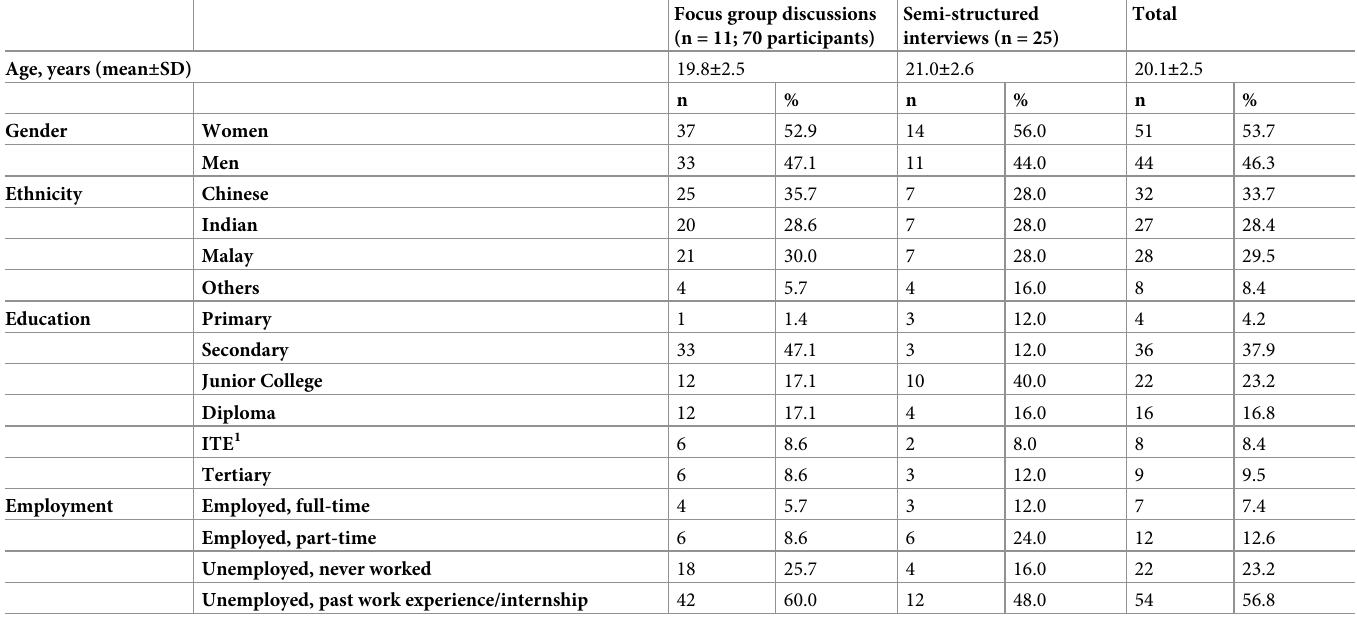
Table 2. Sociodemographic characteristics of the study